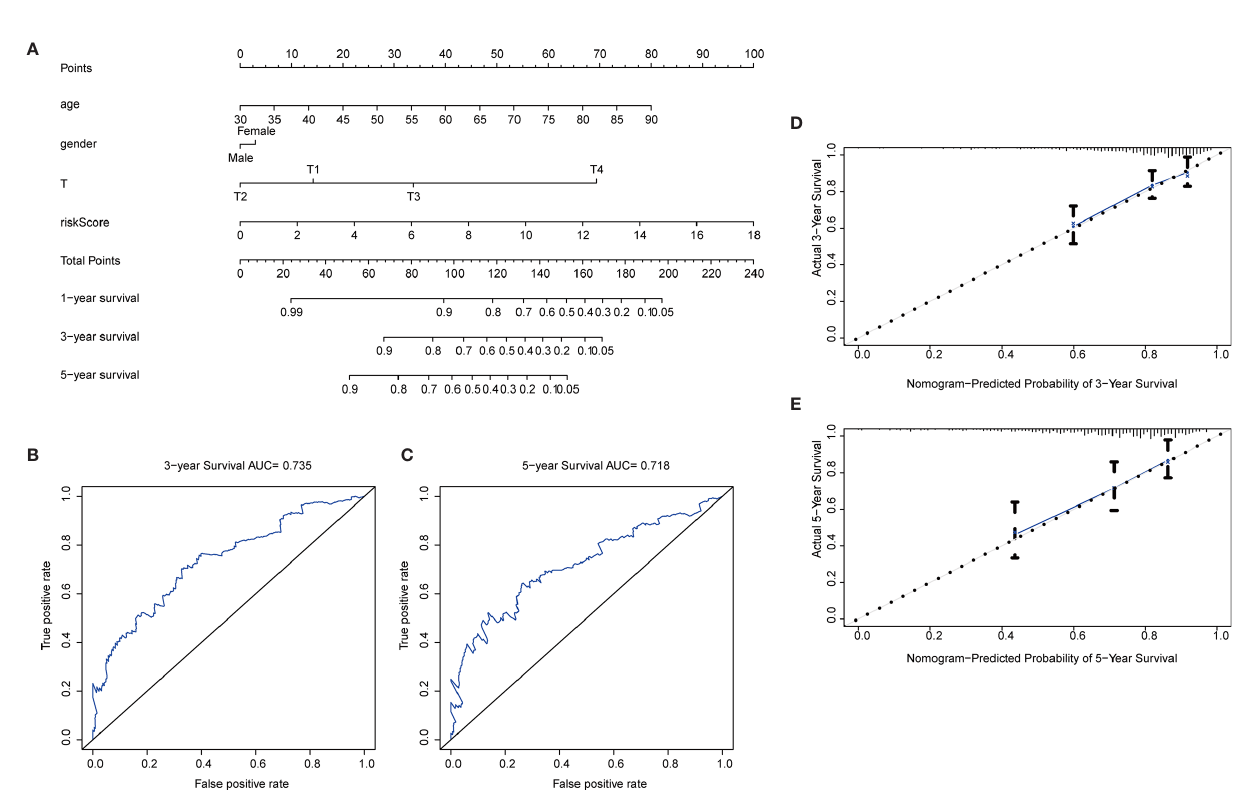
FIGURE 7 | Nomogram construction. (A) Nomogram. Predictive characteristic factors consisted of sex, age, T-stage and risk parameters. (B – C) Time-dependent ROC curves. Assessment of model accuracy, 3-year AUC = 0.735 and 5-year AUC = 0.718. (D – E) Nomogram calibration curves. 3-year and 5-year calibration curves are close to the standard